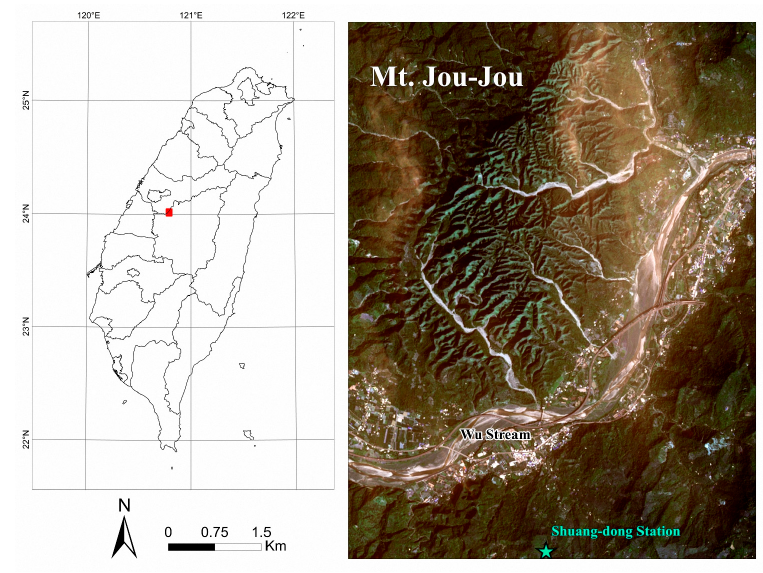
Figure 1. Mt. Jou-Jou location.